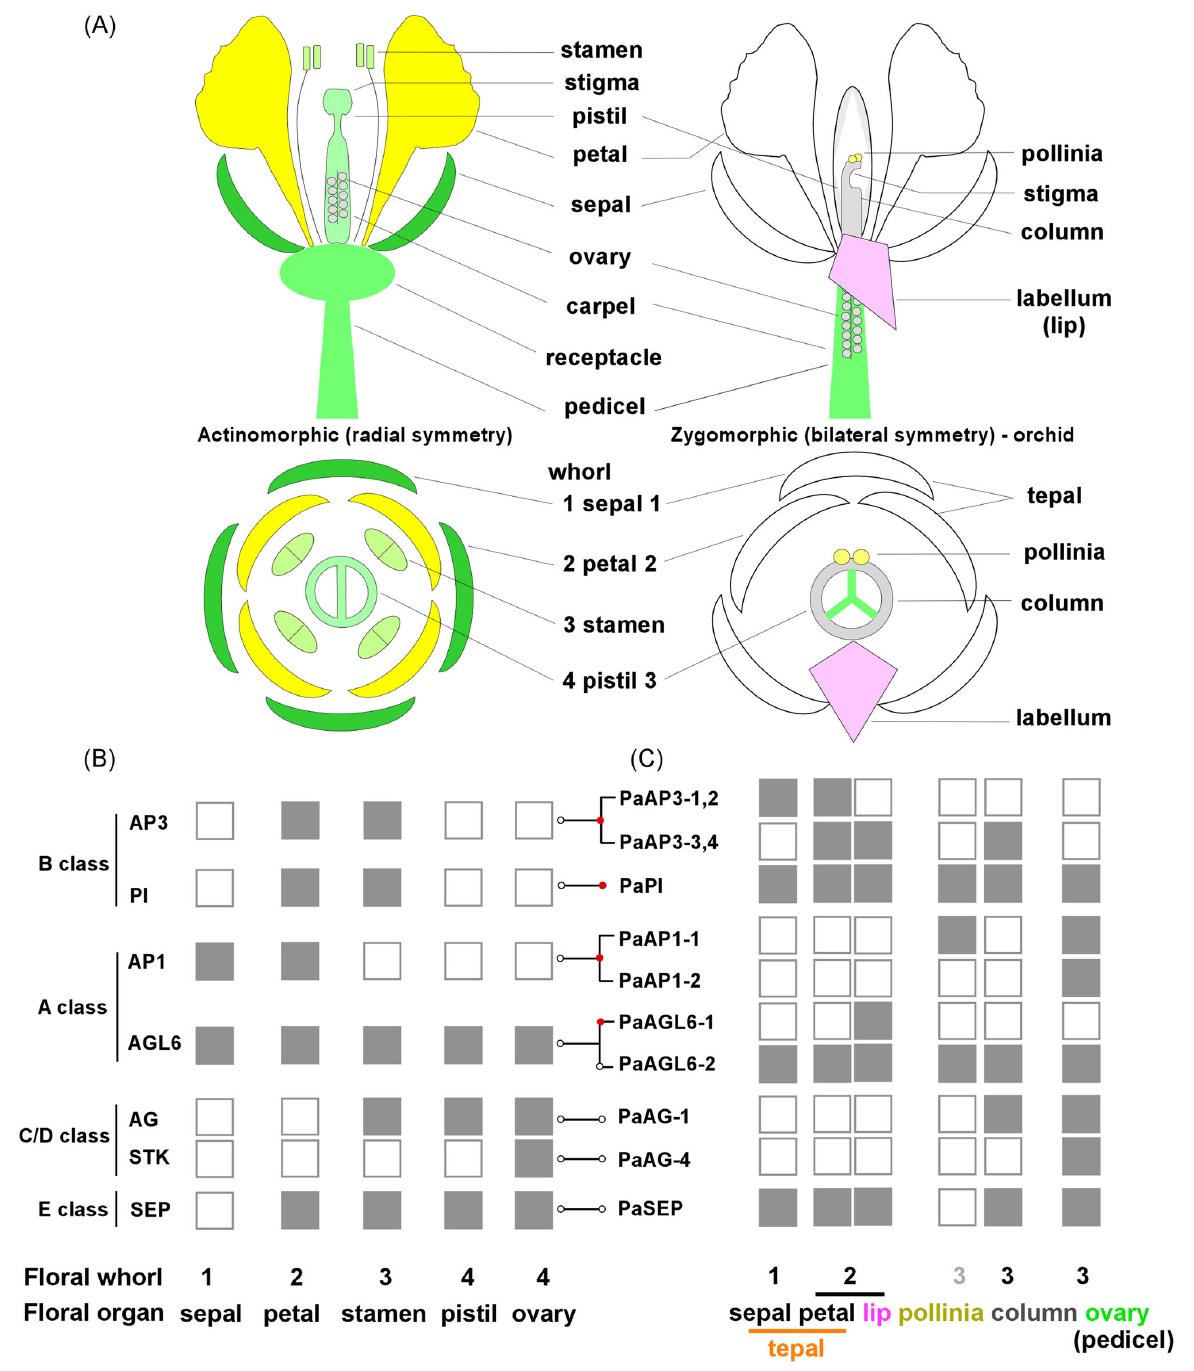
Figure 3. Comparative models of flower development in actnomorphic and zygomorphic angiosperms including morphological variation and distribution of transcription factors. (A) Arrangement of floral organs in radial symmetry as seen in most angiosperms and the bilateral symmetrical arrangement seen in orchid. Top views of both types of flowers show the arrangement of whorls of organs. The orchid flower lacks the stamen whorl and pollinia are attached to the apex of the column. (B) Flowering model showing classes of functional transcription factors discovered from studies of Arabidopsis [43,58,59]. (C) Flowering model showing transcription factors identified to be floral organ-specific in P . aphrodite . Solid boxes indicate the presence of gene expression and empty boxes indicate the absence of gene expression. The connecting line between panel C and panel B indicates phylogenetically related genes. Red dots indicate diversification of spatial distribution and open dots indicate conserved distribution. doi: 10.1371/journal.pone.0080462.g003 PLOS ONE |